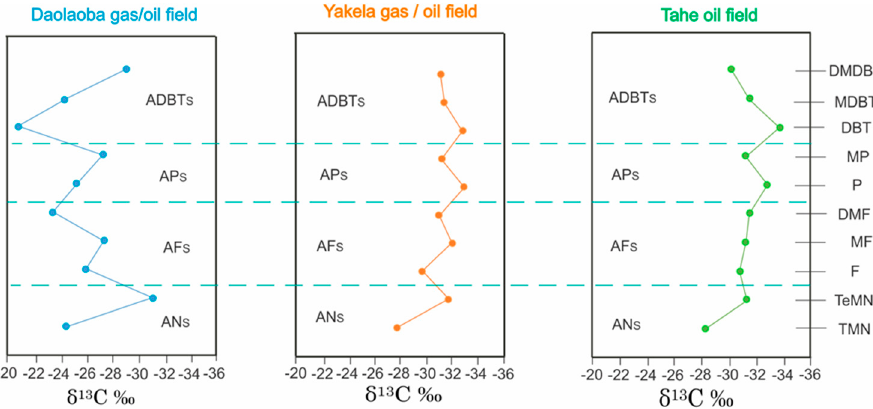
Figure 4. Tendencies of individual aromatic δ 13 C values in oilfields from Tarim Basin (ANs: alkylnaphthalenes; AFs: alkylfluorenes; APs: alkylphenanthrenes; ADBTs: alkyldibenzothiophenes). Table 2. List of crude oils and related individual and sub-classes’ carbon isotopes.